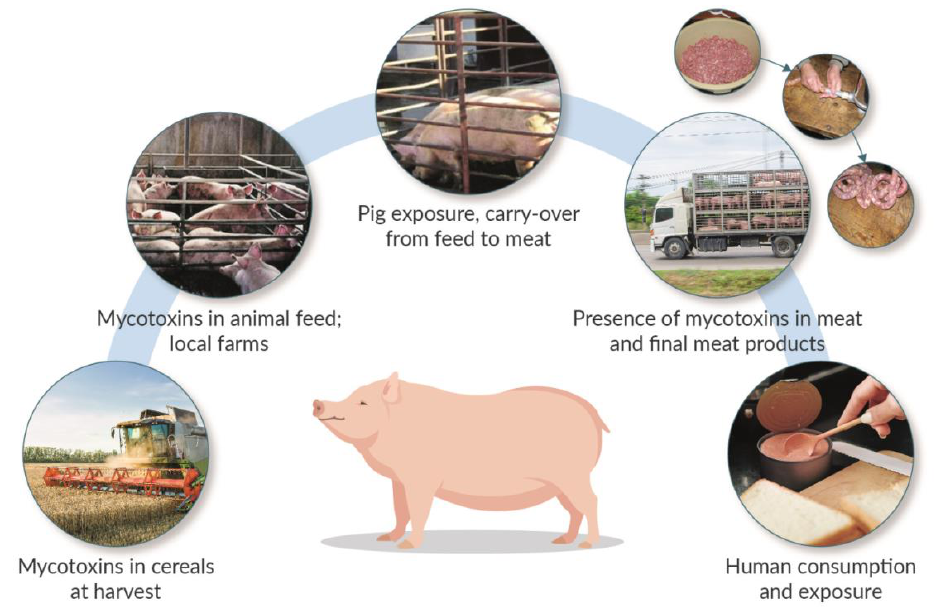
Figure 2. Carry-over of mycotoxins from contaminated cereals and feed into final meat products. Transfer ratios vary; when it comes to skeletal muscles, the values are below 1%, while in the case of blood serum and fat tissue they are higher. Due to their detoxification role, higher carry-over ratios can be seen in liver and kidney. Once taken up by the host organism, these toxins initially reach the blood stream, where they can be found in measurable concentrations. Völkel et al. [62] concluded that carry-over ratios do not vary only across toxin types and animal host species, but also across various tissues sampled from a single host.